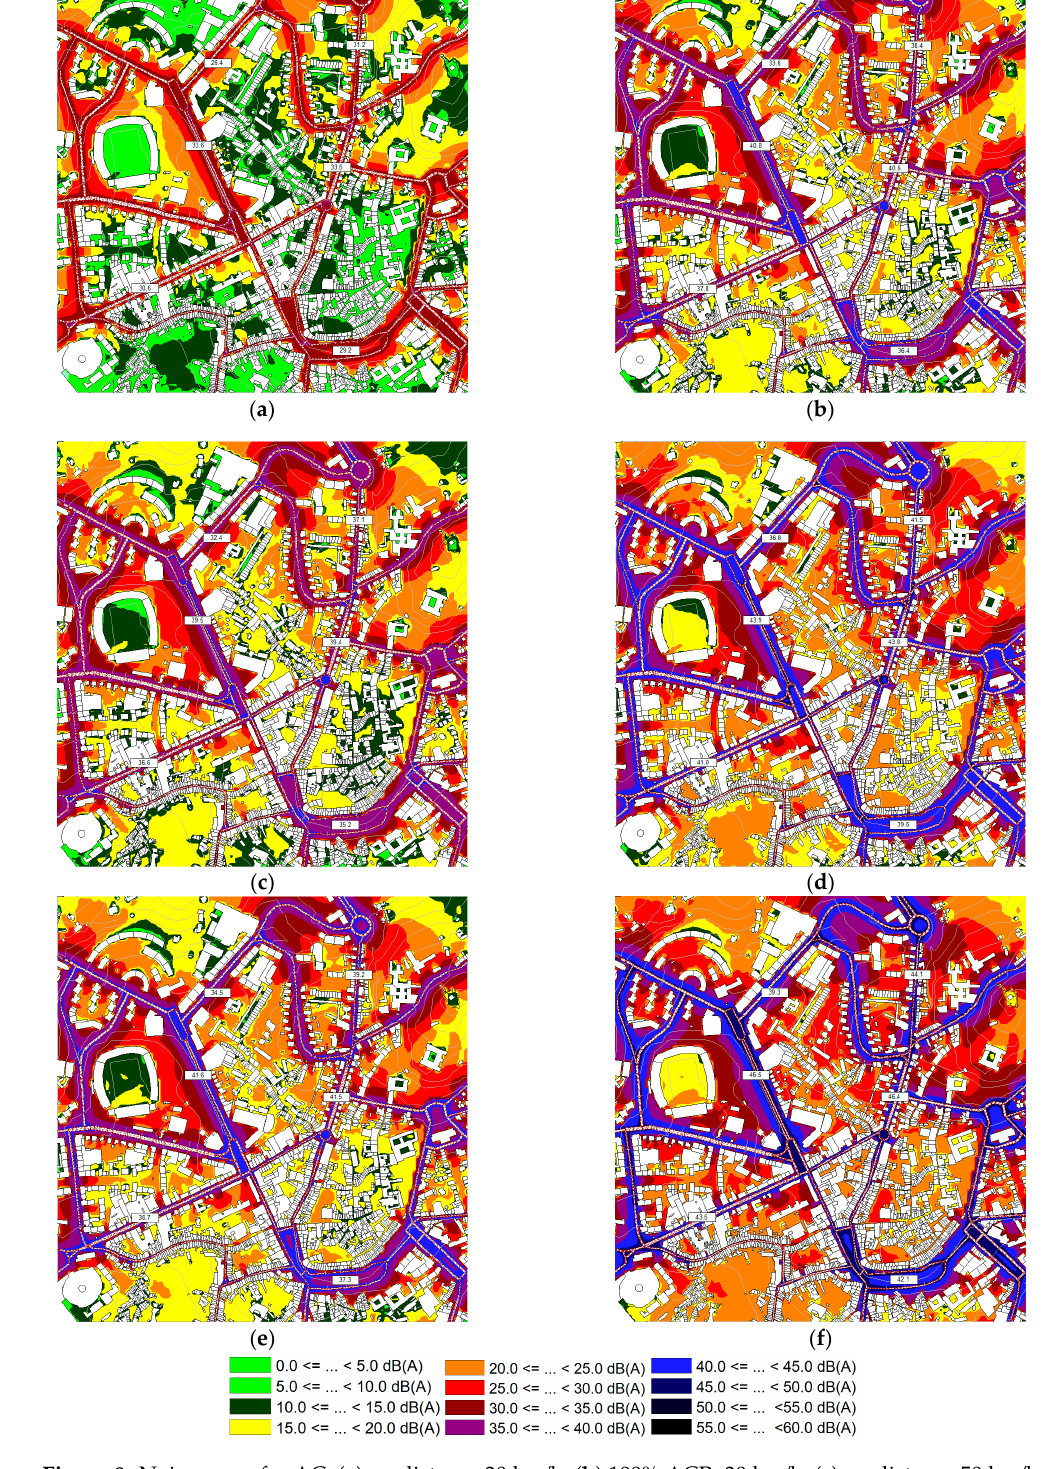
Figure 8. Noise maps for AC: ( a ) no distress, 30 km/h; ( b ) 100% ACR, 30 km/h; ( c ) no distress, 50 km/h; ( d ) 100% ACR, 50 km/h; ( e ) no distress, 65 km/h; ( f ) 100% ACR, 65 km/h.